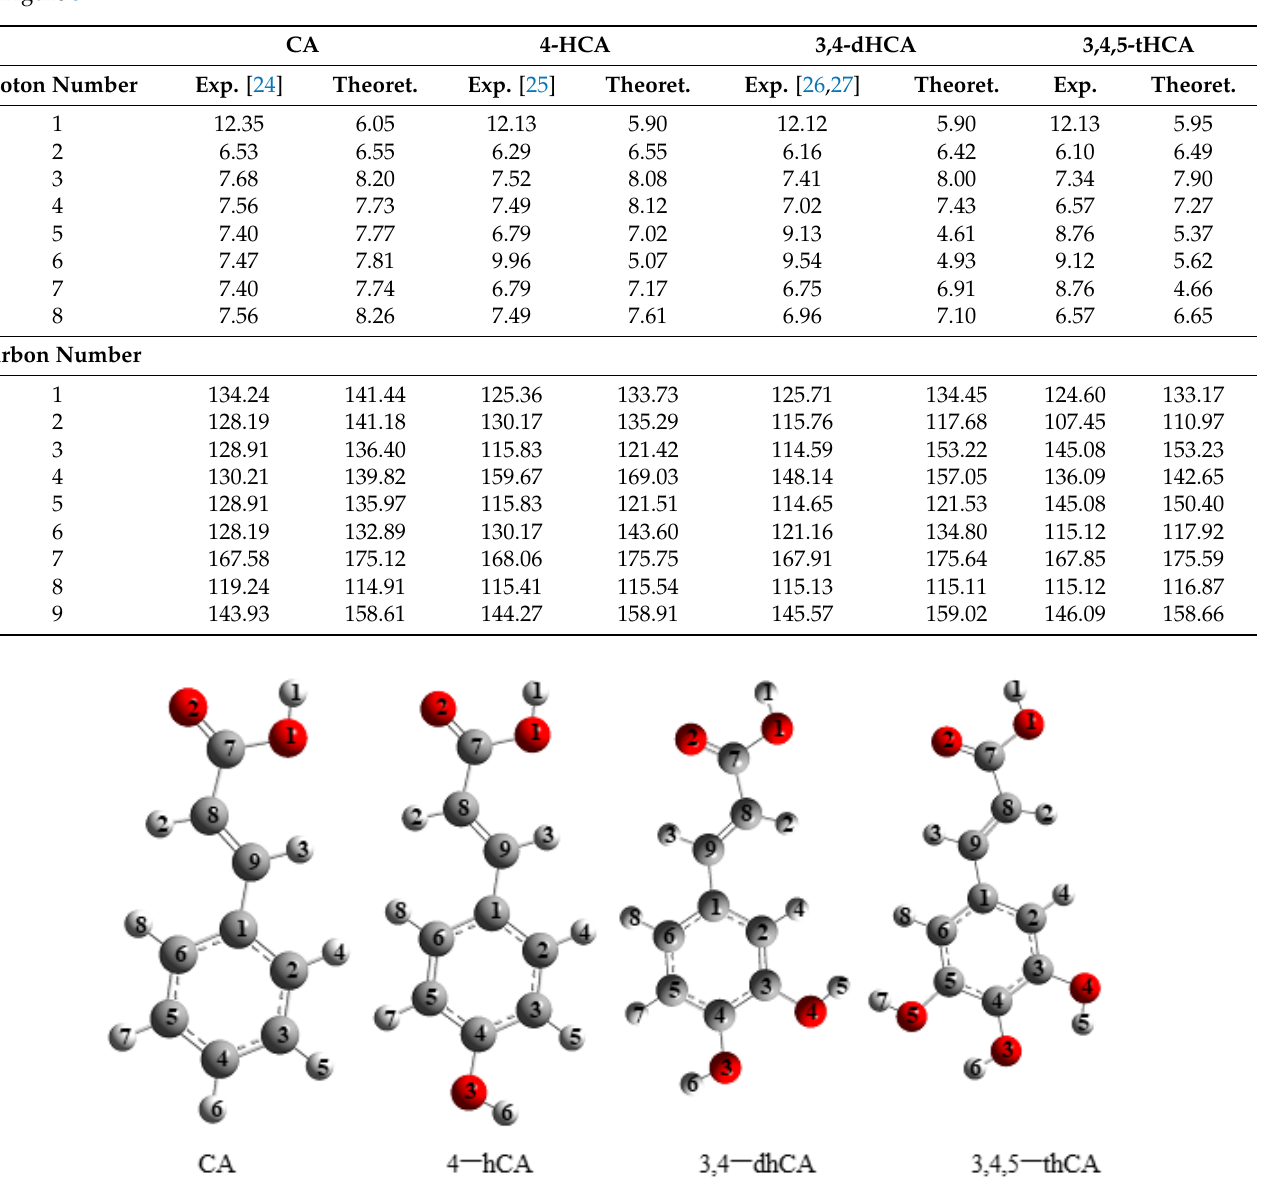
Figure 3. Atom numbering of cinnamic acid and its derivatives (structures optimized in B3LYP/6-311**(d,p) level).